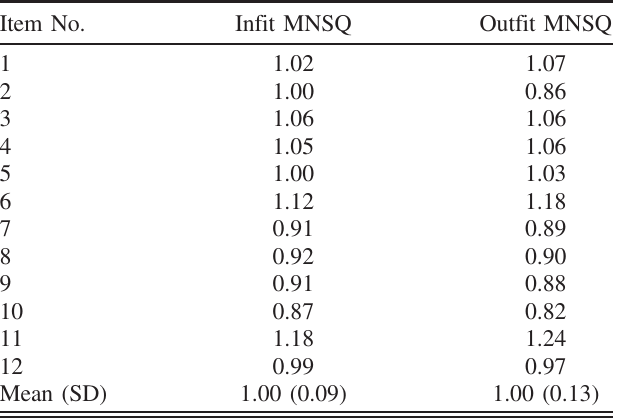
TABLE V. Item statistics: Item infit MNSQ (mean square) and outfit MNSQ statistics for each item j .